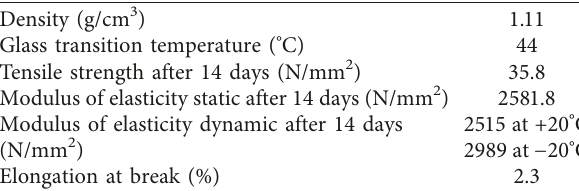
Table 3: Bicomponent epoxy resin characteristics.